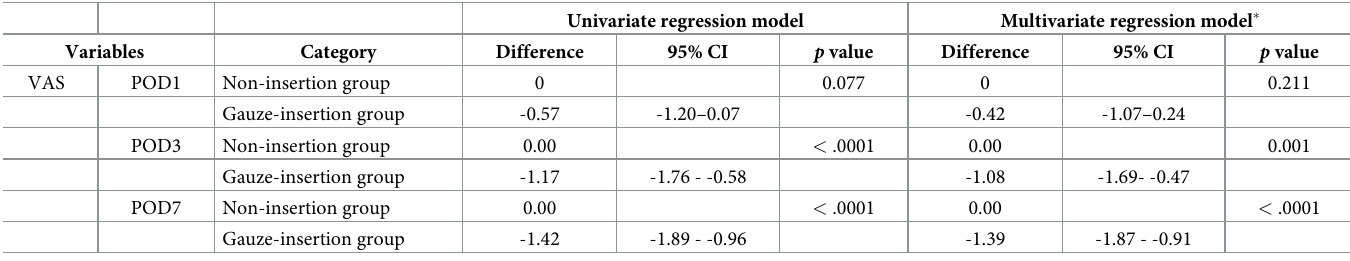
Table 3. VAS values for spontaneous post-extraction pain with regression